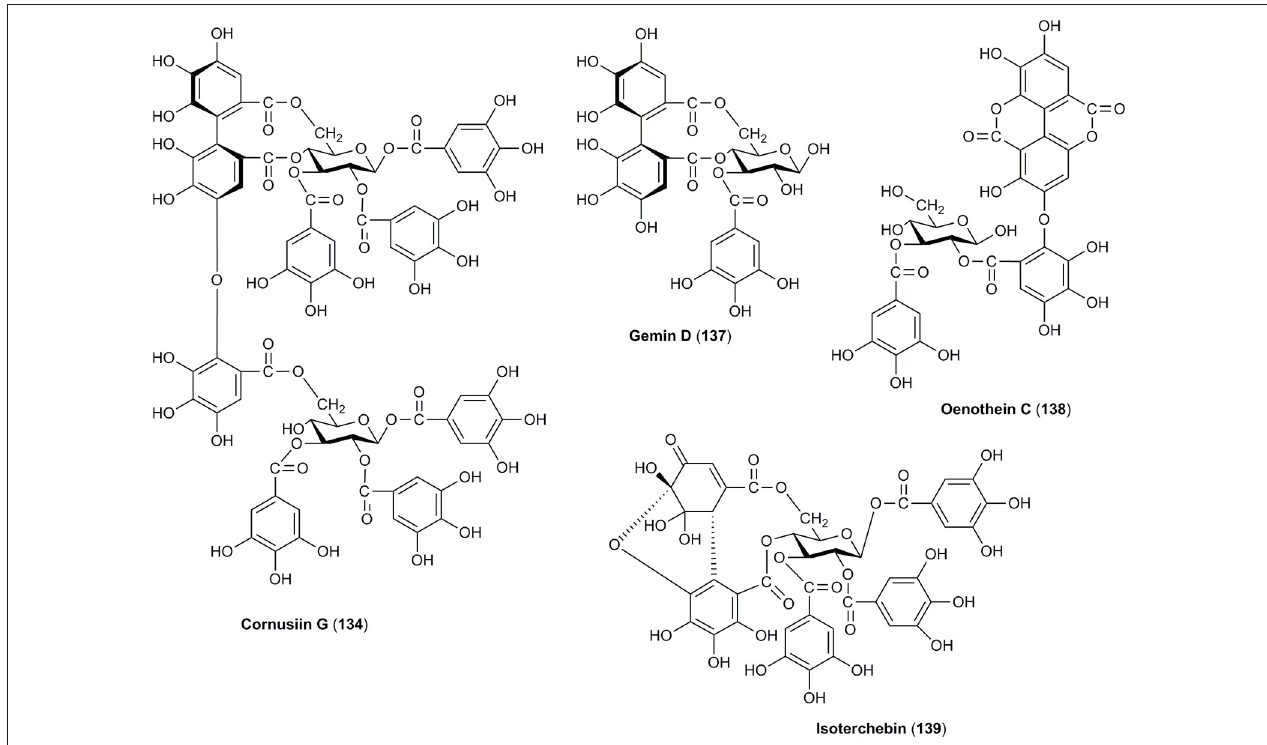
FIGURE 6 | The chemical structures of tannins (continued) identified in fruits of C. officinalis .